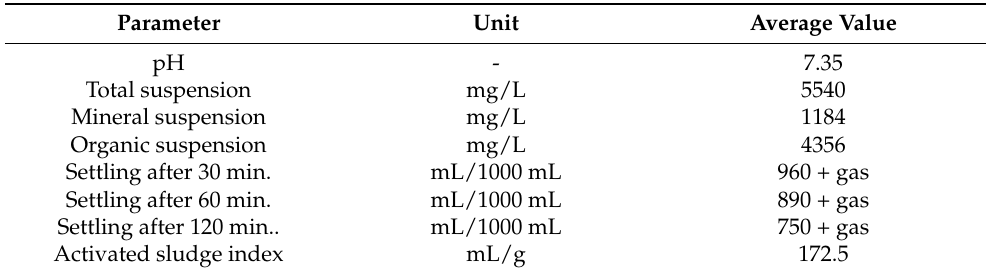
Table 4. Parameters of activated